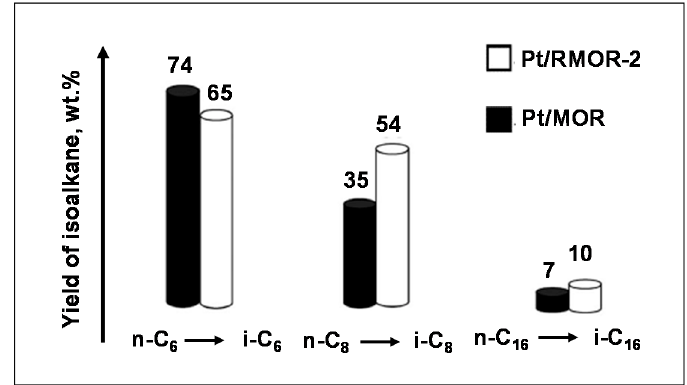
Figure 17. The yields for iso -alkanes in the hydroisomerization of n -hexanes (C 6 ), n -octanes (C 8 ) and n -hexadecanes (C 16 ) over the Pt/recrystallized composite (RMOR-2) relative to the parent MOR. Adapted with permission from [28]. Copyright Royal Society of Chemistry, 2013.